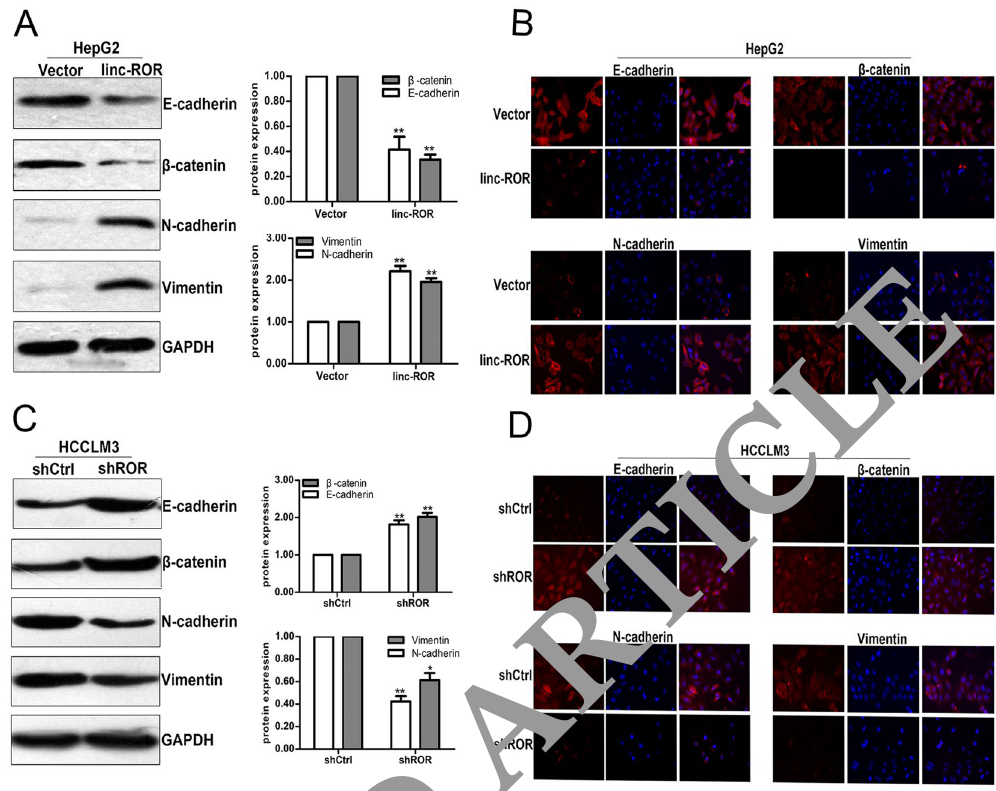
Figure 3. Linc-ROR induces EMT in HCC cells. ( A ) Western blotting and ( B ) immunofluorescence detection of epithelial markers (E-cadherin and β -catenin) and mesenchymal markers (N-cadherin and Vimentin) in HepG2 cells stably transfected with linc-ROR or Vector. ( C ) Western blotting and ( D ) immunofluorescence detection of epithelial markers (E-cadherin and β -catenin) and mesenchymal markers (N-cadherin and Vimentin) in HCCLM3 cells stably transfected with shROR or shCtrl, respectively. Each experiment was performed at least three times. * p < 0.05; ** p <